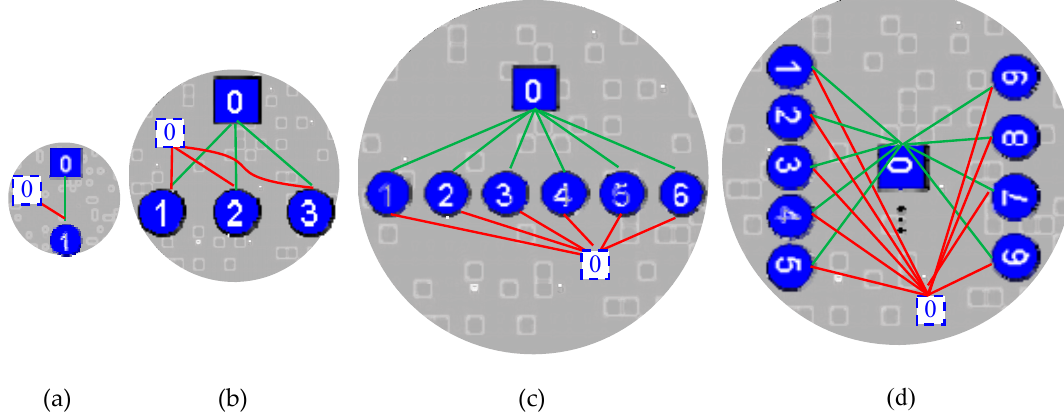
Figure 5. Distributed embedded system deployment in a complex environment.